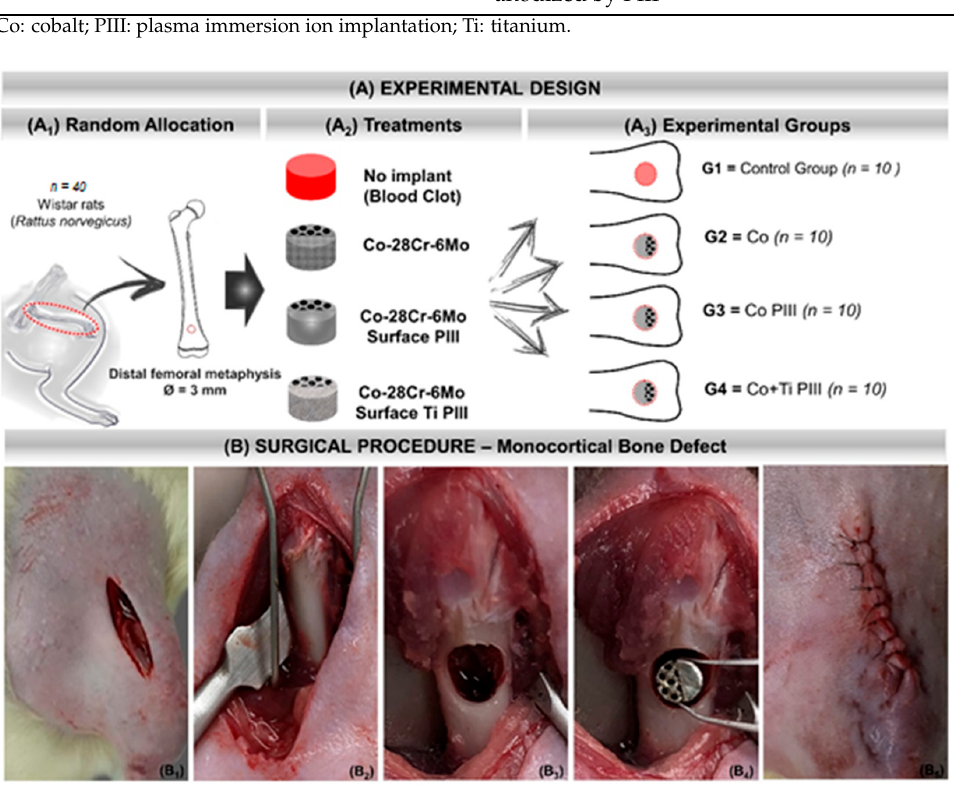
Figure 1. ( A ) Experimental design. ( A1 ) Random Allocation—Forty adult male Wistar rats ( Rattus norvegicus ), 120 days old, weighing around 340 g. Monocortical bone defect model 3 mm in diameter in the distal metaphysis of the left femur. ( A2 ) Treatments—groups according to the type of implant or not: No implant (blood clot), Co-28Cr-6Mo, Co-28Cr-6Mo with surface nanostructured by PIII and Co-28Cr-6Mo with surface coated with Ti and nanostructured by PIII. ( A3 ) Experimental groups: G1 ( n = 10)—bone defect filled with blood clot, no implant; G2 ( n = 10)—bone defect filled with Co-28Cr-6Mo implant; G3 ( n = 10)—bone defect filled with Co-28Cr-6Mo implant with surface nanostructured by PIII; G4 ( n = 10)—bone defect filled with Co-28Cr-6Mo implant with surface coated with Ti and nanostructured by PIII. ( B ) Surgical procedure. ( B1 ) Skin incision on the anteromedial aspect of the thigh. ( B2 ) Exposure of the cortical bone of the surgical area. ( B3 ) 3 mm bone defect in the distal metaphysis of the femur. ( B4 ) Implantation of the metallic alloy in the surgical bed. ( B5 ) Tegument suture with 5-0 nylon thread.